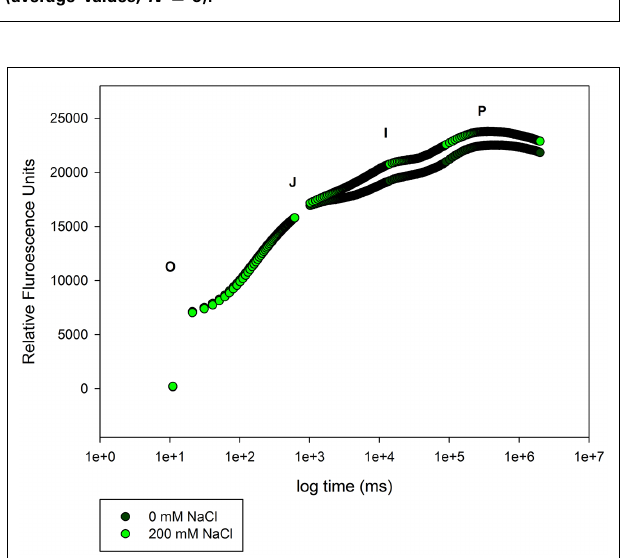
FIGURE 6 | Rapid transient OJIP curve calculated parameters (Phi P 0 , maximum yield of primary photochemistry; Phi E 0 , probability that an absorbed photon will move an electron into the ETC; N, the number of quinone turnovers until maximum fluorescence is